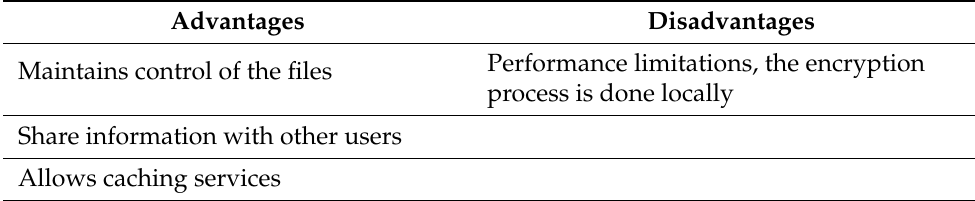
Table 3. Advantages and disadvantages of distributed cloud